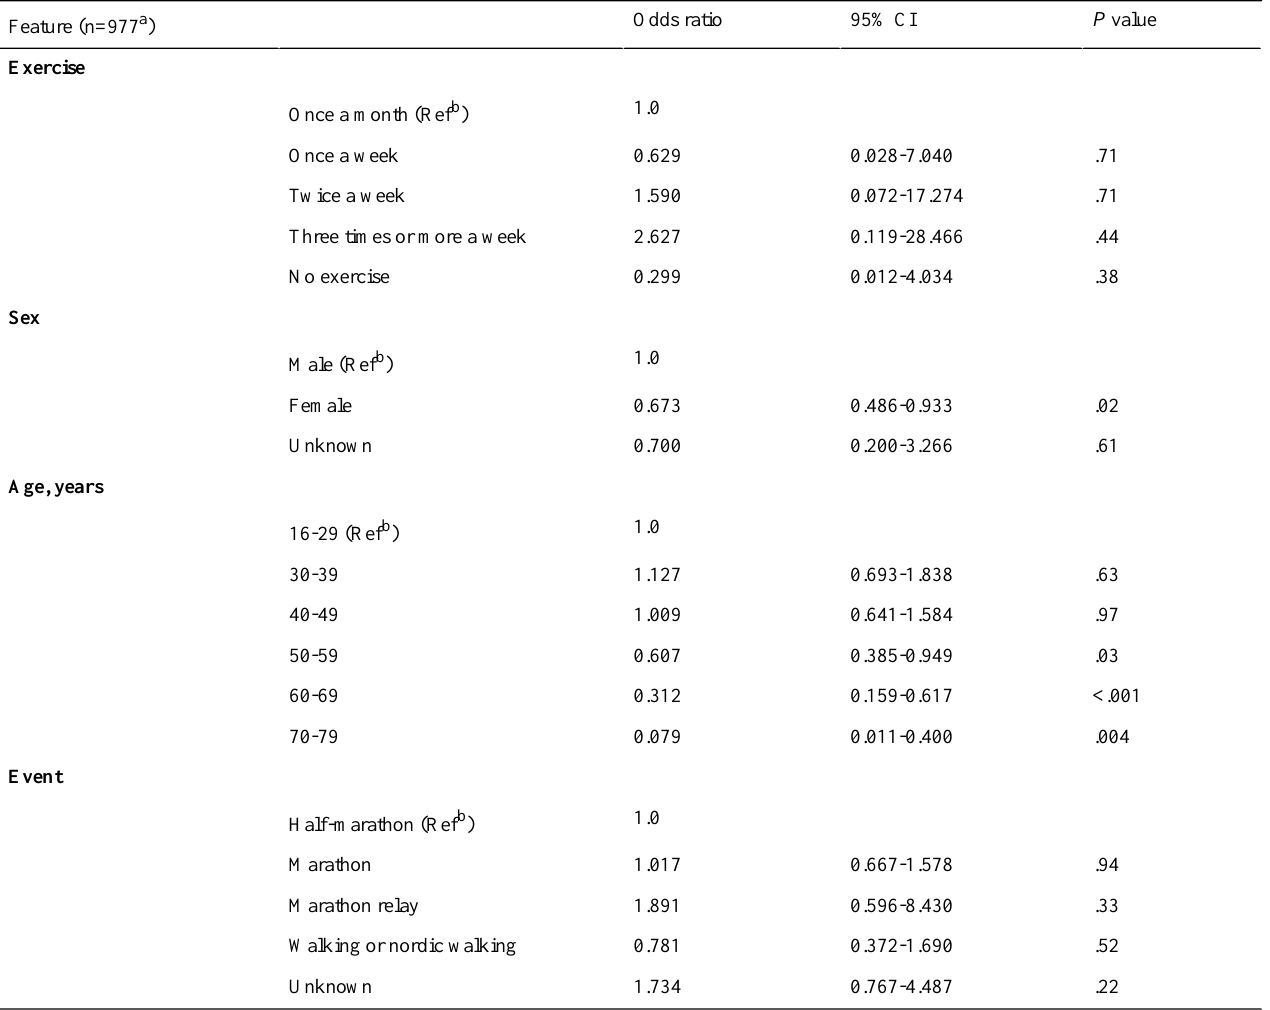
Table 3. Features associated with wearable devices and training optimization or distance tracking